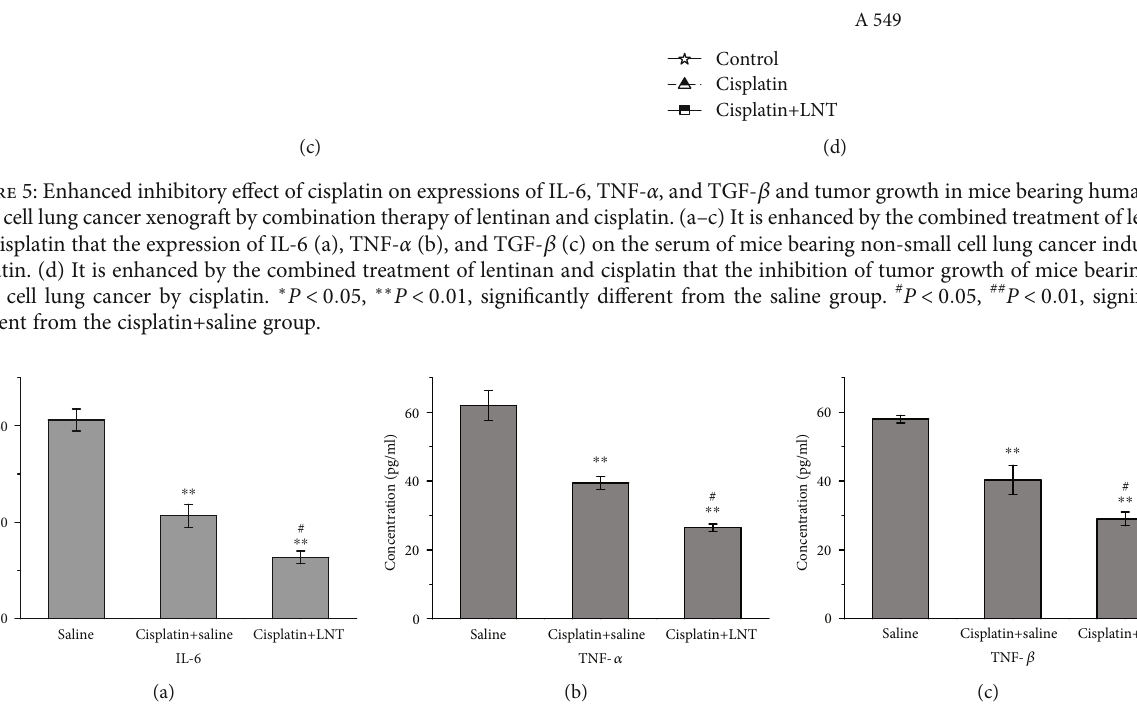
Figure 6: The expression of IL-6, TNF- α , and TGF- β on the tumor of tumor-bearing mice with non-small cell lung cancer. (a – c) The expression of IL-6 (a), TNF- α (b), and TGF- β (c) on the tumor cell suspension supernatant of tumor-bearing mice with non-small cell lung cancer after the combined treatment of lentinan and cisplatin. ∗ P < 0 : 05 , ∗∗ P < 0 : 01 , signi fi cantly di ff erent from the saline group. # P < 0 : 05 , ## P < 0 : 01 , signi fi cantly di ff erent from the cisplatin+saline